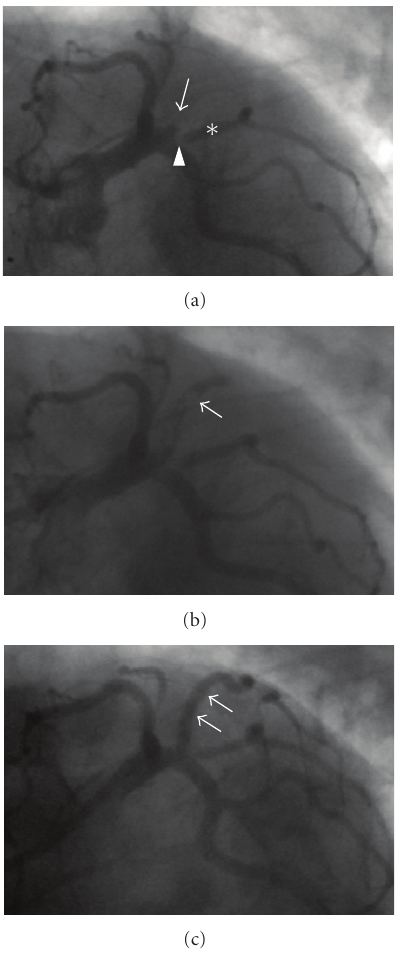
Figure 1: (a) Coronary angiography showing a total occlusion of the 1st left posterolateral branch of the left circumflex artery (see arrow), an ostial stenosis (see arrow head) of the 2nd left posterolateral branch (proximal to the bare-metal stent), and a patent bare-metal BeStent (see asterisk). (b) Coronary angiography demonstrating stent occlusion of sirolimus-eluting stent and exten- sive thrombus after guidewire passage (see arrow). (c) Coronary angiography documenting vessel patency after balloon